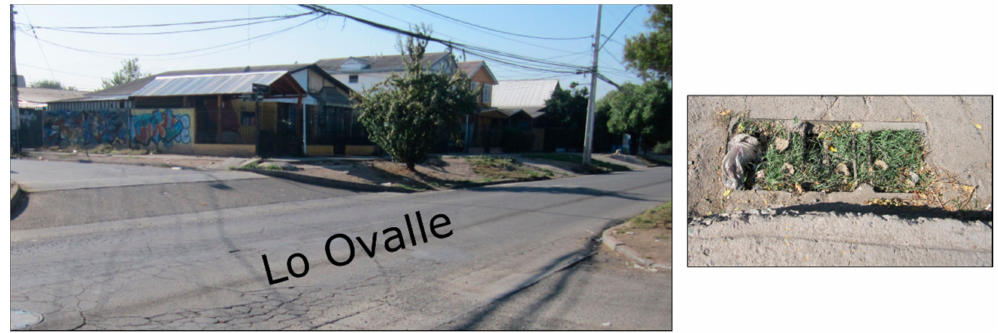
Figure 4. Quilicura: The street “Lo Ovalle” turns into a riverbed during rainfalls due to its lower level compared to the side streets. Blocked gullies increase the runoff (photos taken by author, Quilicura, 6 May